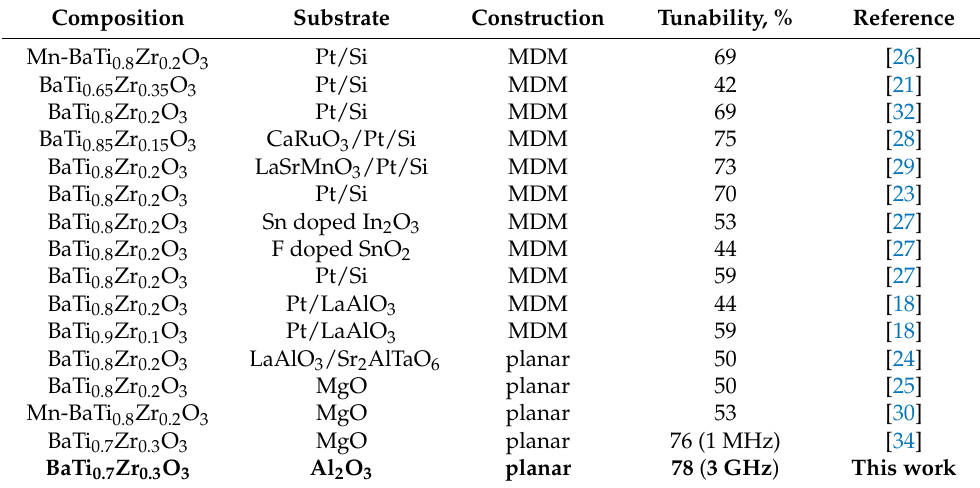
Figure 7. The 2 GHz Q-factor of planar capacitors based on BZT films subjected to annealing at various temperatures. various temperatures. Table 2. Data on the tunability of MDM and planar capacitors based on barium titanate–zirconate